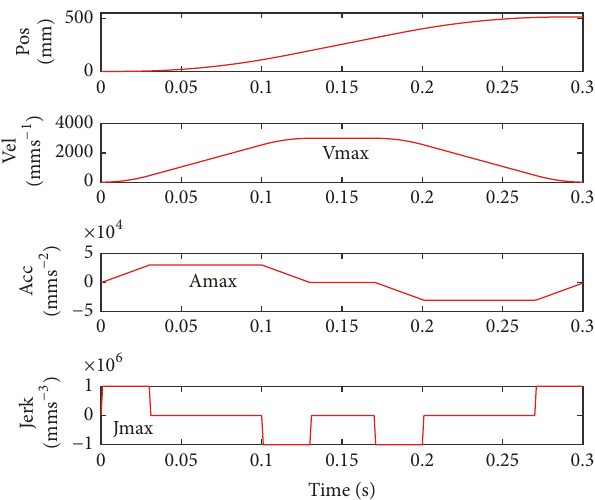
Figure 3: An example plot of jerk-limited acceleration